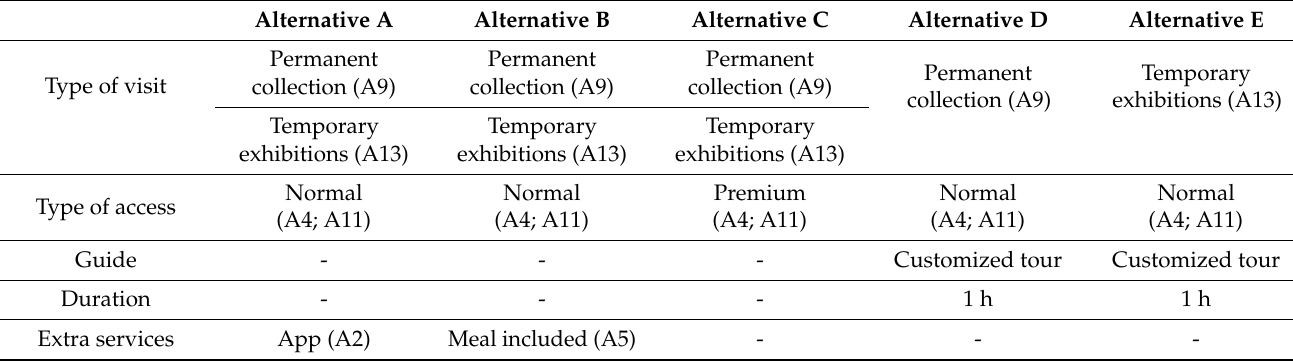
Table 1. A sample choice set used in this